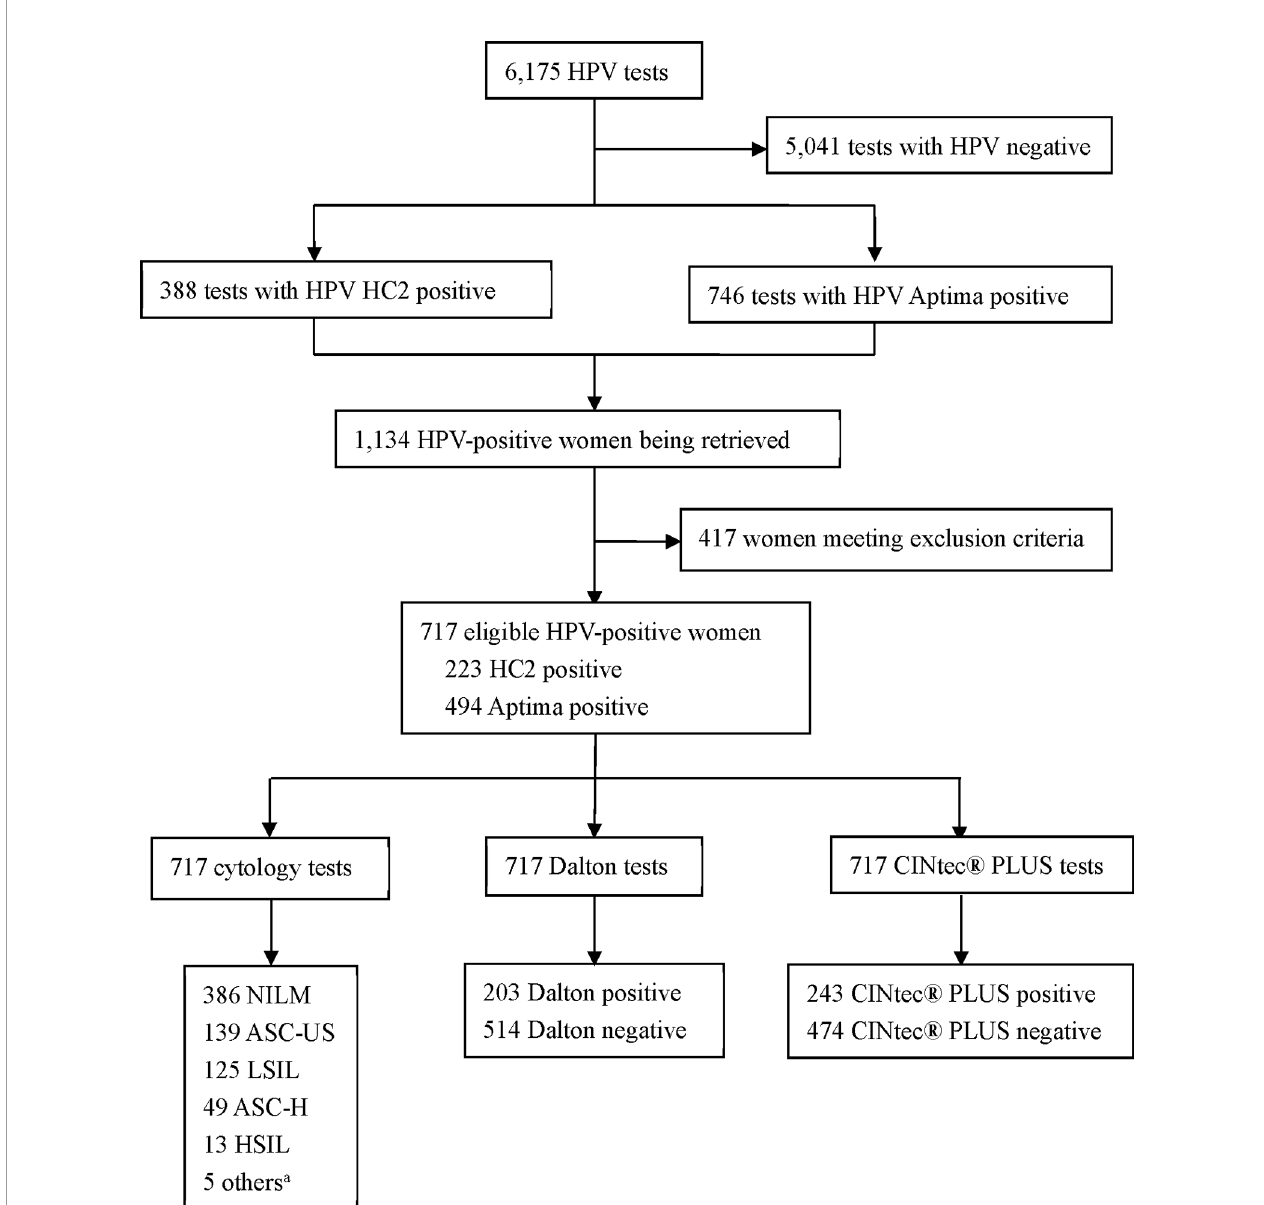
FIGURE 1 | Flowchart of subject recruitment. HPV, human papillomavirus; NILM, negative for intraepithelial lesion or malignancy; ASC-US, atypical squamous cells of undetermined signi fi cance; LSIL, low-grade squamous intraepithelial lesion; ASC-H, atypical squamous cells, cannot rule out high-grade squamous intraepithelial lesion; HSIL, high-grade squamous intraepithelial lesions. a Included 3 of SCC (squamous cell carcinoma), 1 of AC (adenocarcinoma) and 1 of AGC-NOS (atypical glandular cell of undetermined signi fi